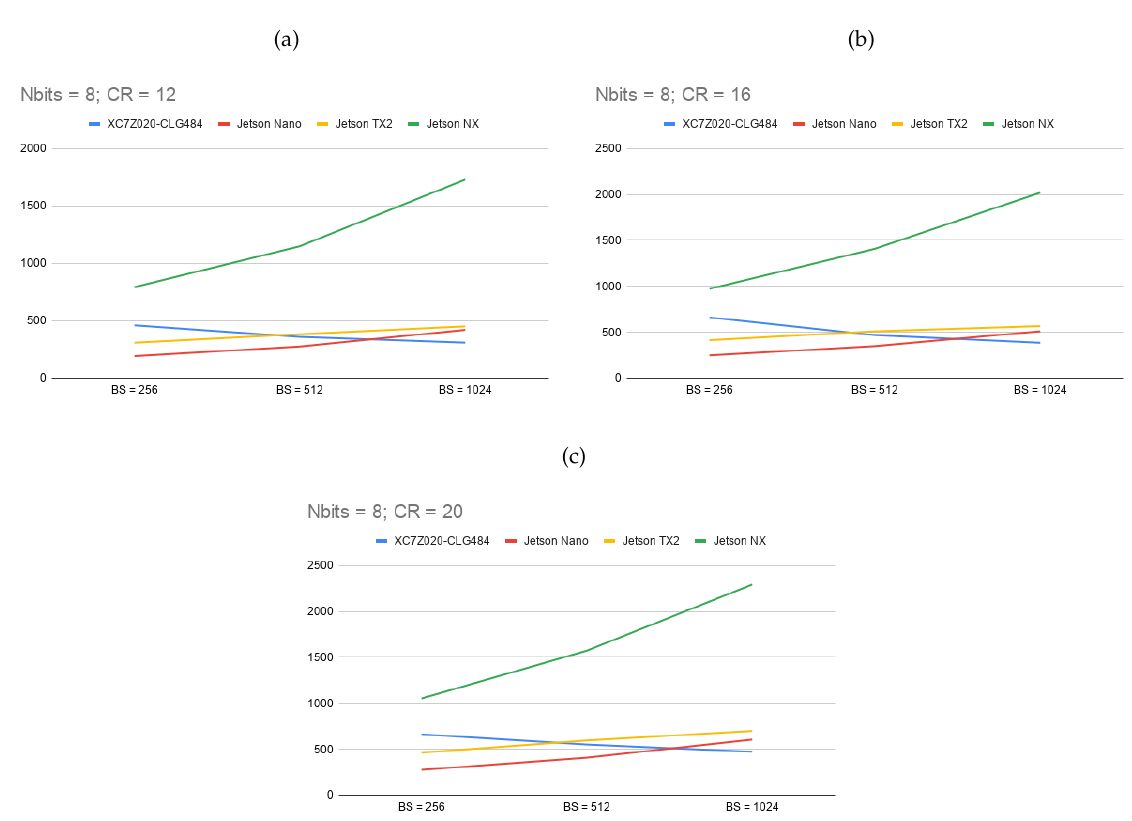
Figure 13. Comparison of the speed-up obtained in the compression process, in terms of FPS and the input parameter BS , reached by a Xilinx Zynq-7020 programmable SoC following the design-flow proposed in this work versus the GPU-based implementation model described in [29] performed onto some NVIDIA power-efficient embedded computing devices, such as Jetson Nano, Jetson TX2 and Jetson Xavier